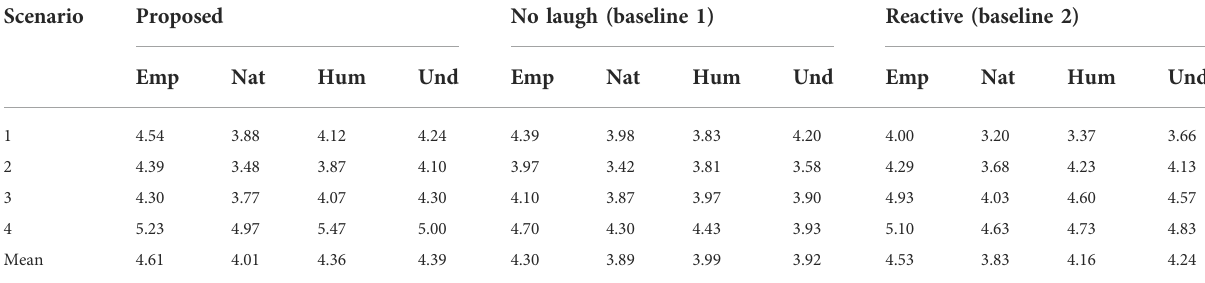
TABLE 6 Mean values on evaluation scores in a subjective experiment (Emp: empathy, Nat: naturalness, Hum: human likeness, Und: understanding).